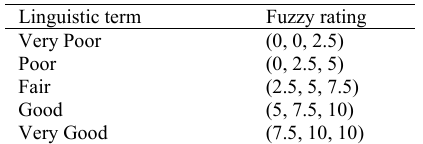
Table 1: Linguistic rating of alternatives (Yazdani et al., 2011)